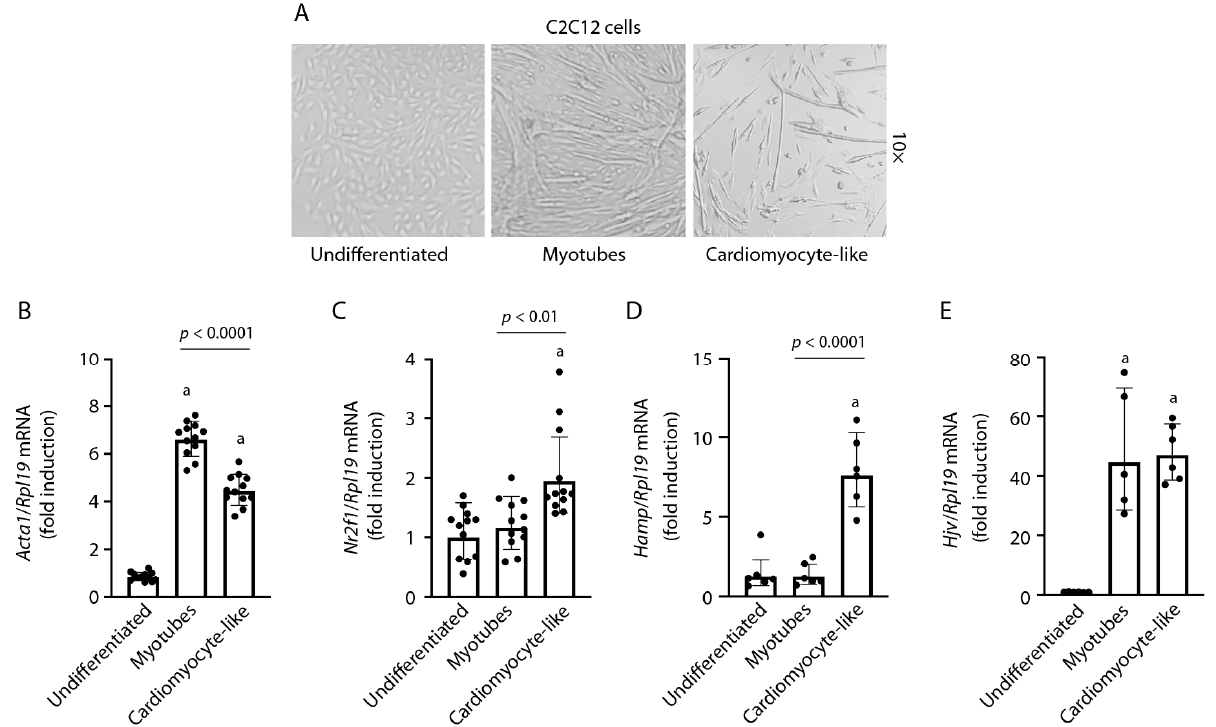
Figure 1. Differentiation of C2C12 myoblasts into a cardiomyocyte-like phenotype. Undifferentiated C2C12 cells were maintained in media containing 20% fetal bovine serum. Differentiation into myotubes was induced by decreasing fetal bovine serum to 2%; addition of 500 nM retinoic acid promoted differentiation into a cardiomyocyte-like phenotype. ( A ) Morphology of undifferentiated C2C12 myoblasts and differentiated myotubes and cardiomyocyte-like cells; magnification: 10 × . ( B – E ) qPCR analysis of Acta1 , Nr2f1 , Hamp, and Hjv mRNAs. Gene expression data are represented as geometric mean ± geometric standard deviation. Statistically significant differences ( p < 0.05) versus undifferentiated cells are indicated by a .